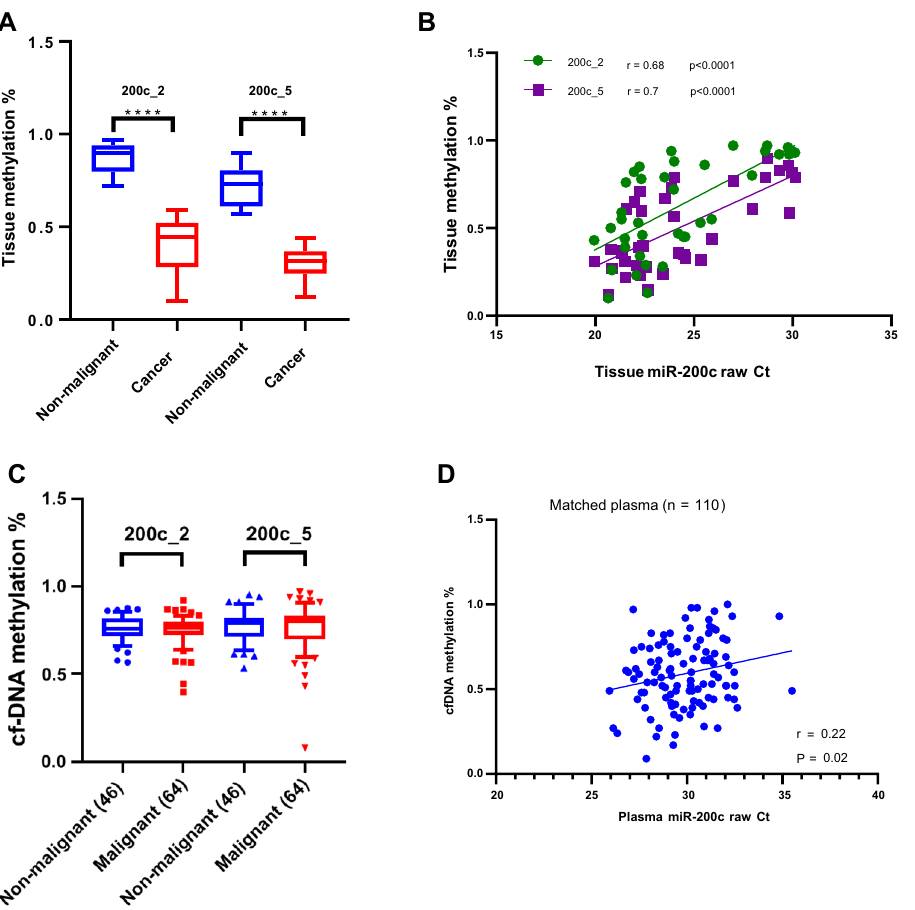
Figure 5. miR-200c expression correlates with promoter methylation in OC tissues but not in cfDNA. Quantitative DNA methylation analysis of the miR-200 promoter in a panel of non-malignant and cancer tissues is depicted as percentage where ****P < 0.0001 ( A ). DNA methylation correlated with matched miRNA expression, plotted as raw Ct values, in corresponding tissues (n = 38) ( B ). Quantitative DNA methylation analysis of the miR-200 promoter in cfDNA of non-malignant and malignant OC ( C ) and one representative CpG site *P < 0.05 ( D ). The correlation between cfDNA methylation and miRNA expression is shown ( E